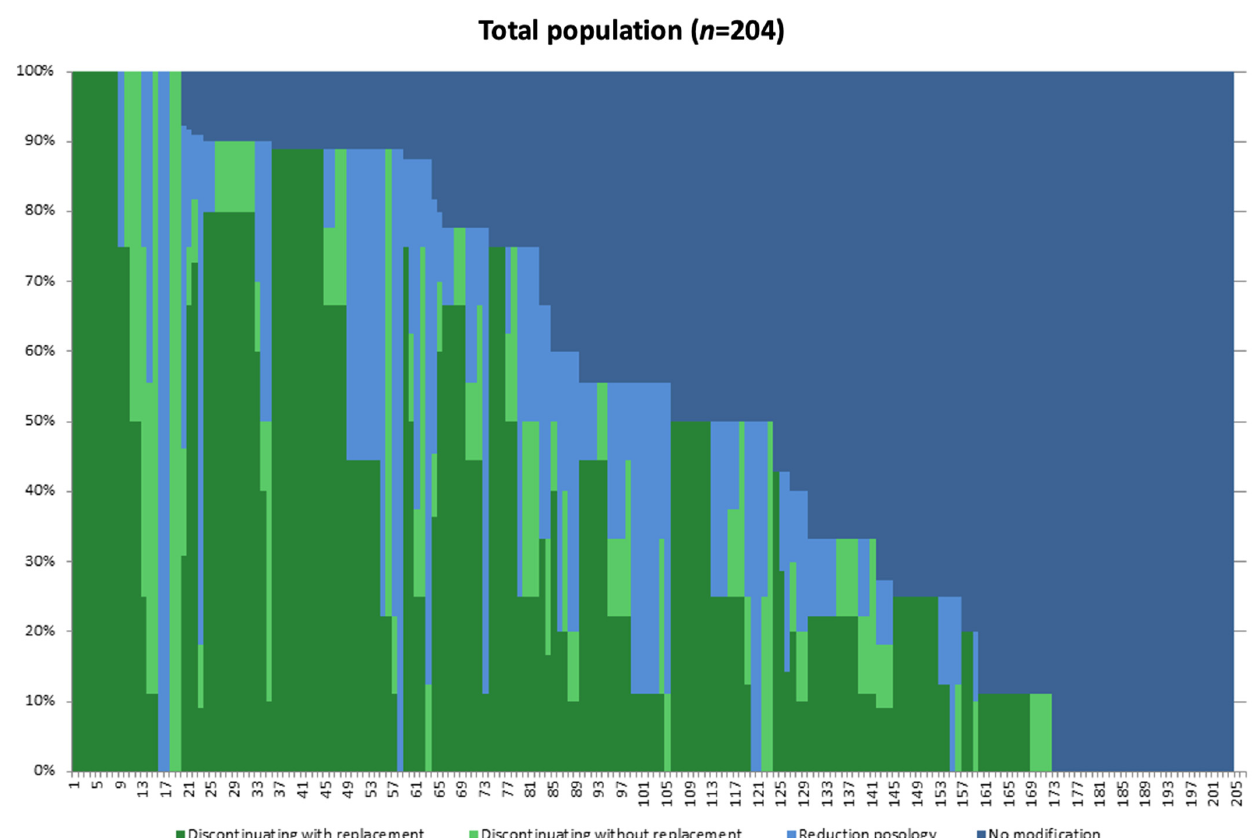
Figure 1. Percentages of population of patients concerned by each strategy for every GP. Legend: GPs are represented individually on x-axis (one vertical line represents one GP) and proportion of patients declared by GPs (as percentages) concerned by each strategy are represented on y-axis. For example, GP 37 had applied discontinuation with replacement strategy for 80% of his patients, whereas the no modification strategy has been applied for 20% of this GP patients.